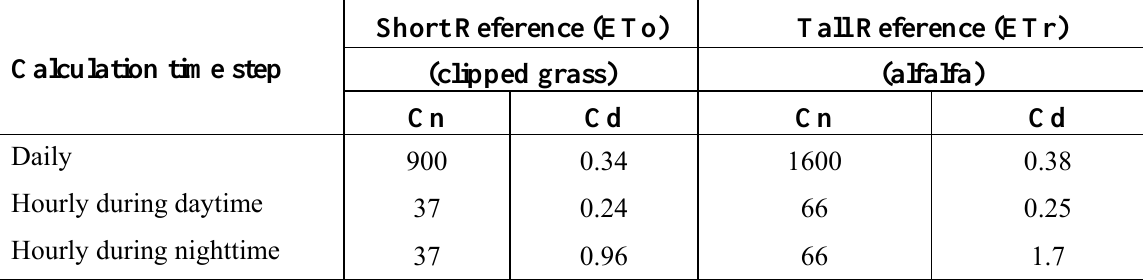
Table 4. Values of coefficients for reference ET